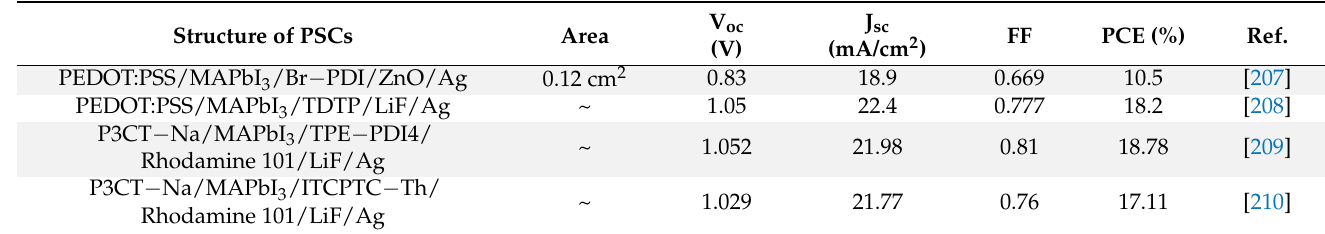
Table 18. Performances of several representative inverted PSCs on the basis of organic small − molecule materials